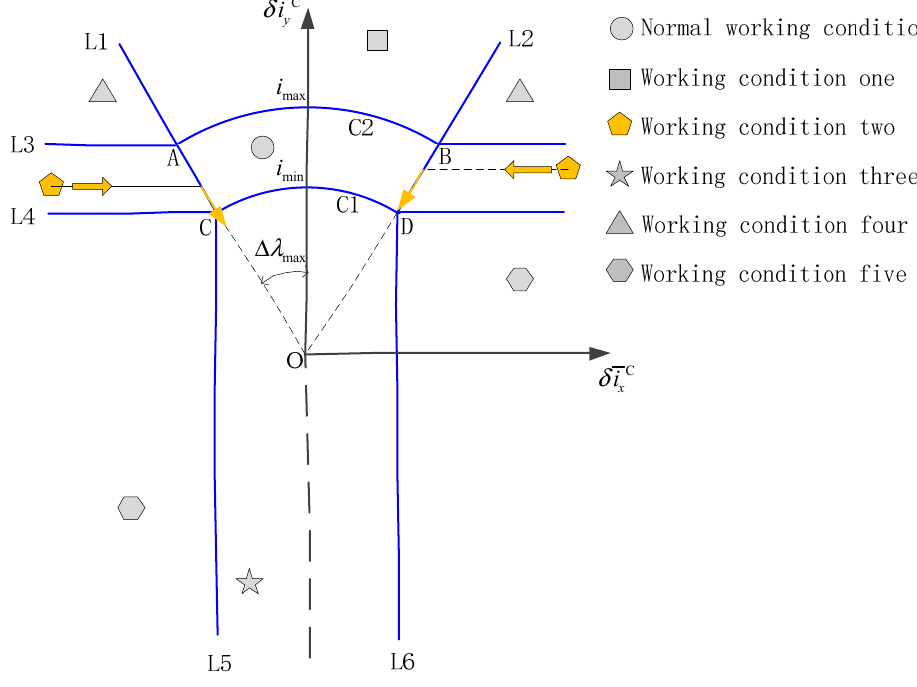
Figure 9. The NSSK in working condition two. In Figure 9, the starting point of the straight line arrow is located on the straight line AC or BD between the C2 circle and the C1 circle, indicating that the SK duration is between the shortest and longest duration. The straight-line arrows point in the AC direction, indicating that the SK control points remain unchanged in the inertial space. The 45 ◦ arrow points to the normal zone, indicating that working condition two will enter the normal working condition in one